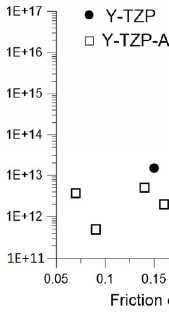
Fig. 10 AE energy vs. friction coefficient.